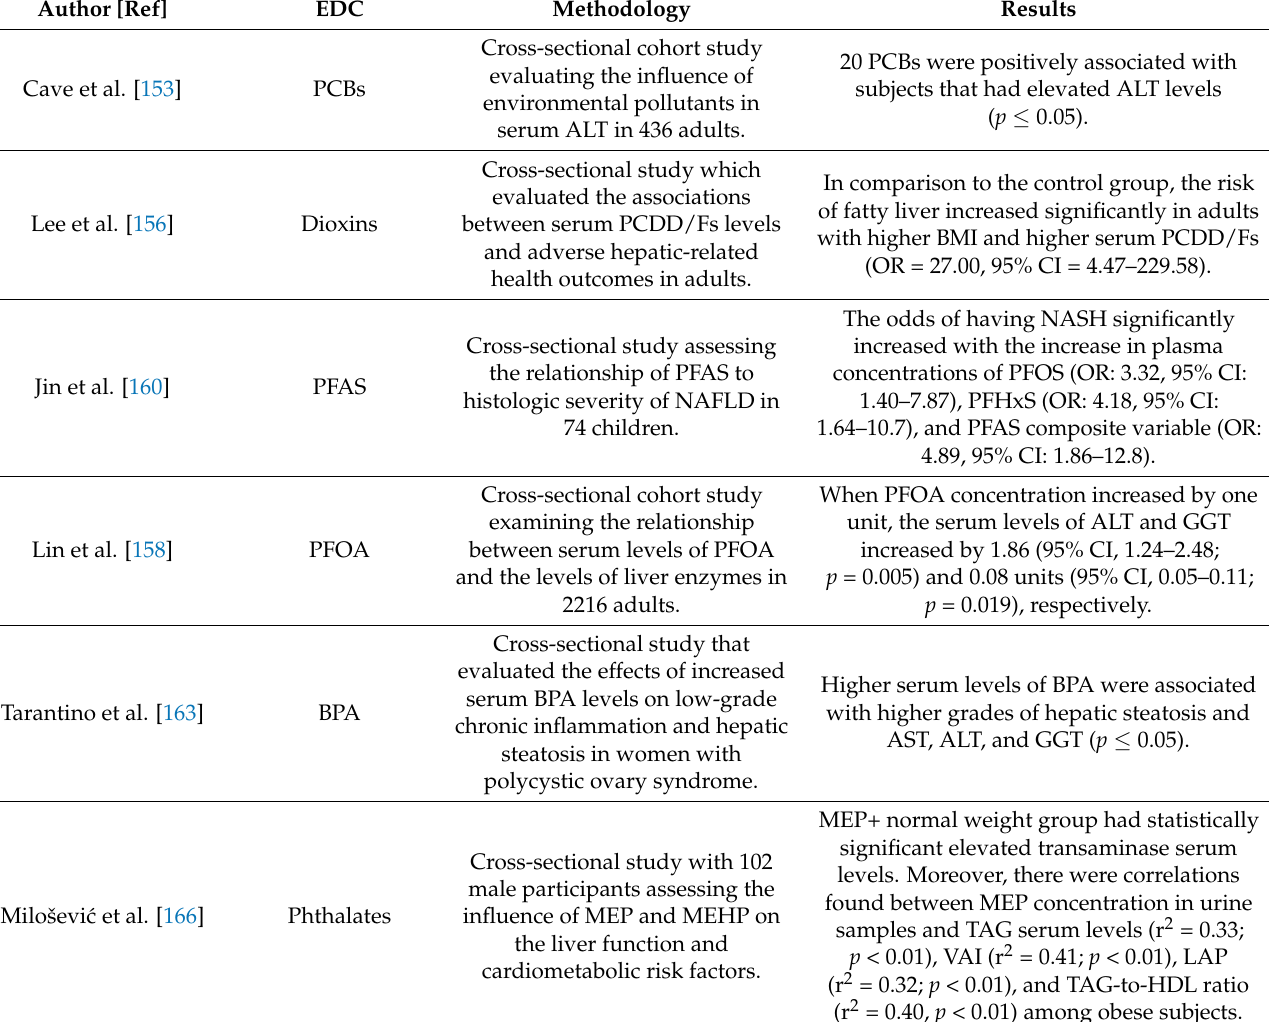
Table 2. Summary of the clinical evidence regarding endocrine-disrupting chemicals and non-alcoholic fatty liver